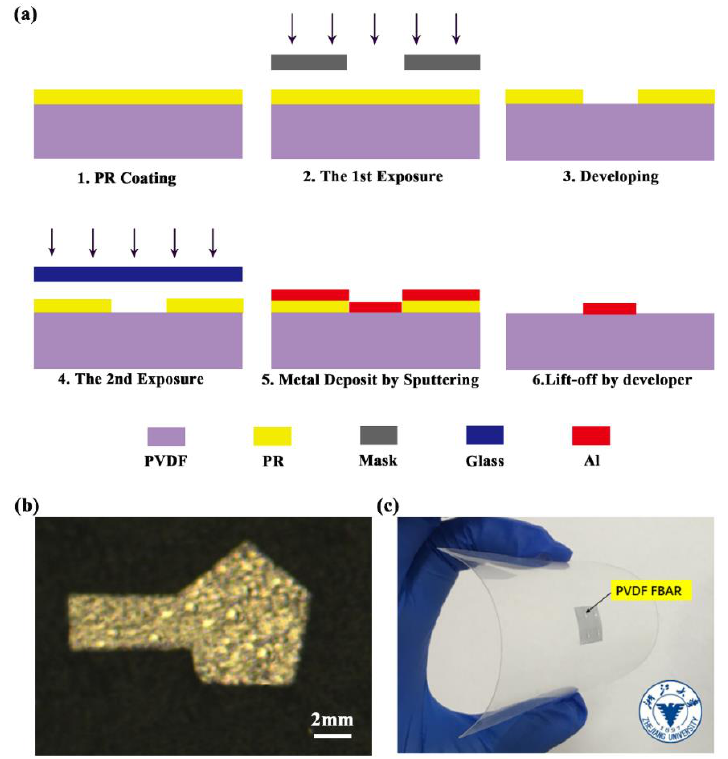
Figure 3. ( a ) Fabrication process for PVDF FBAR; ( b ) microscope image of fabricated electrode by double-exposure and lift-off process; ( c ) optical photo of fabricated FBAR device, showing its flexibility.